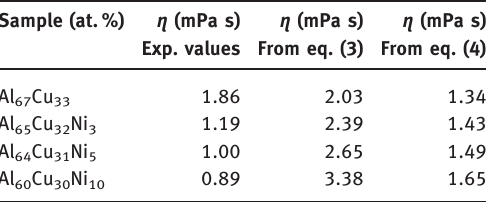
Table 2: Experimental and calculated viscosity values at 1,200 K. Sample